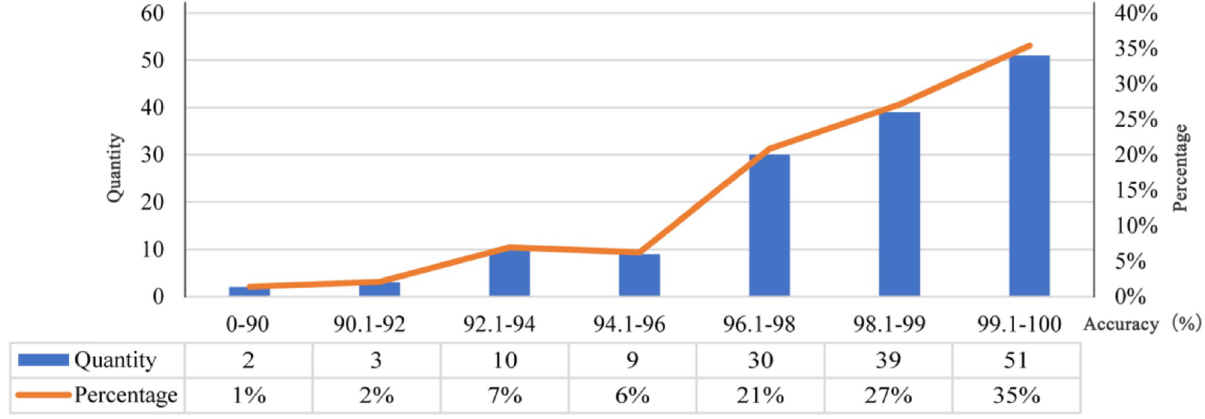
Fig 9. Accuracy distribution of test grains. Note. The horizontal axis is the accuracy rate of recognition by the algorithm; the left longitudinal axis is the quantity, and the right longitudinal axis is the percentage.